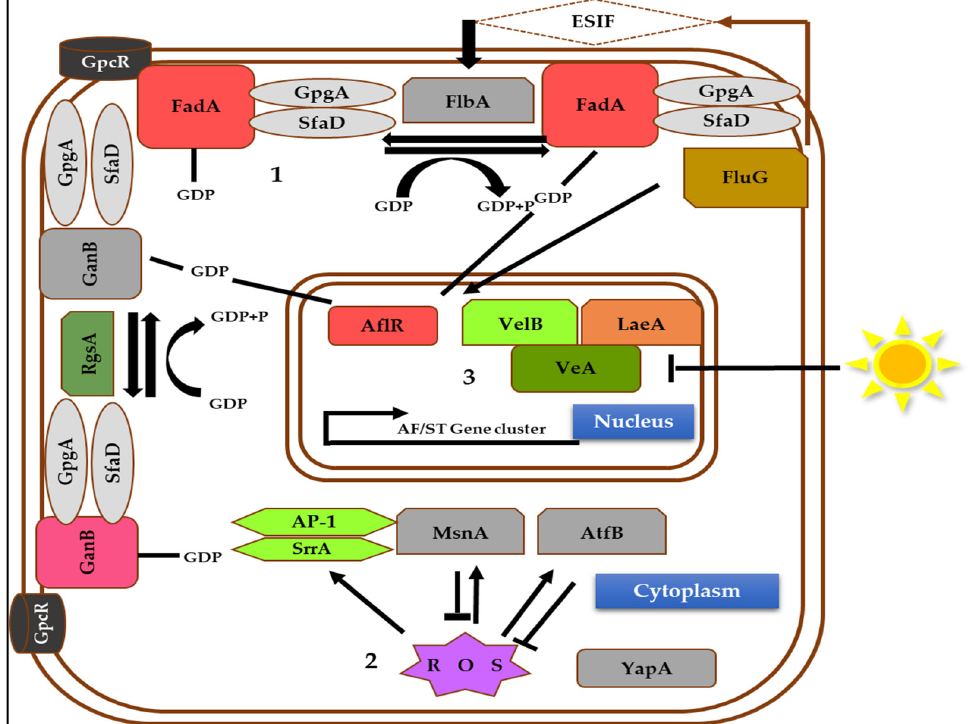
Figure 4. Different upstream elements affecting the AF/ST gene cluster (source: the author). The heterotrimeric G-protein pathways (G proteins) are general transcription regu- lators linked to the plasmid membrane of the cell and function as transduction impulses in reaction to foreign stimuli to maintain the cell’s physiologic conditions. The G proteins have three subunits— α , β , and γ —that abandon their function once reassembled into a trimeric form (Figure 4). The instigation occurs because of GTP binding to the G subunit. Regarding AF biosynthesis, it has been demonstrated that two subunits of G α ( GanB and FadA ) prevent ST/AF synthesis in the presence of GTP through the suppression of aflR activity [48,49]. Nevertheless, it was shown that the G βγ subunits (SfaD and GpgA) stim- ulate ST synthesis, implying that the G protein subunits analyzed have distinct functions in ST biosynthesis [50]. Moreover, the response to Reactive Oxygen Species (ROS) is a second transcription regulator. Figure 4 illustrates a suggested mode of action for such reactions. YapA gene’s mutation increases AF production, indicating that YapA may act as an inhibitor of ROS buildup. It was discovered that in the presence of ROS, four DNA-binding transcriptional factors, such as MsnA , AtfB , and AP-1/SrrA complexes, entangle to the specified DNA to stimulate AF production by boosting AF genes [51]. Similarly, the light-sensitive complex ( VeA , VelB , and LaeA ) is a third transcription regulator (Figure 5) that exhibits a low amount of VeA activity in light inside the cytoplasm. Nonetheless, VeA expression in- creased in the dark and was carried into the nucleus via the importer α carrier (KapA) [52]. Therefore , LaeA should be bound to a VeA/VelB compound to have an inhibitory im- pact over HepA . HepA is a spatial adaptor that plays a vital role in chromatins’ molecular compounds [53,54]. The HepA ’s suppression prevents the transition of heterochromatin towards euchromatin in the aflR region [55].